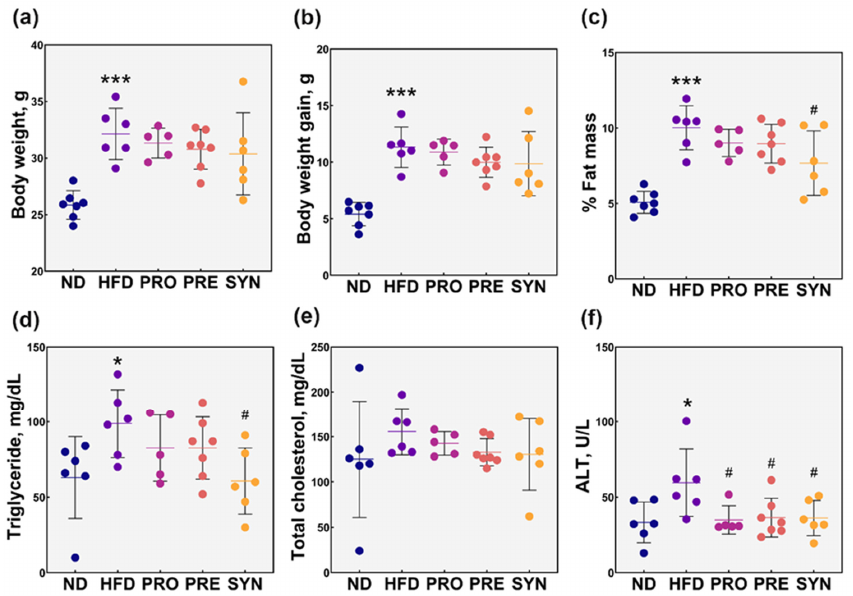
Figure 1. Effect of administration of L. rhamnosus 4B15 and C. tricuspidata on body weight and metabolic parameters. Comparison of the effect of each treatment on the ( a ) body weight, ( b ) body weight gain, ( c ) percent fat mass, ( d ) triglyceride, ( e ) total cholesterol, and ( f ) alanine aminotransferase, ALT of high-fat diet-induced obese mice. Values are presented as mean ± SEM. The significance values [ p < 0.05] and [ p < 0.001] are denoted as *, ***, respectively, in comparison with ND. The significance value [ p < 0.05] is denoted as # in comparison with HFD. Statistical analyses were performed using one-way ANOVA with post-hoc Tukey HSD. ND: normal diet; HFD: high-fat diet; PRO: high-fat diet + L. rhamnosus 4B15; PRE: high-fat diet + C. tricuspidata ; SYN: high-fat diet + L. rhamnosus 4B15 + C. tricuspidata